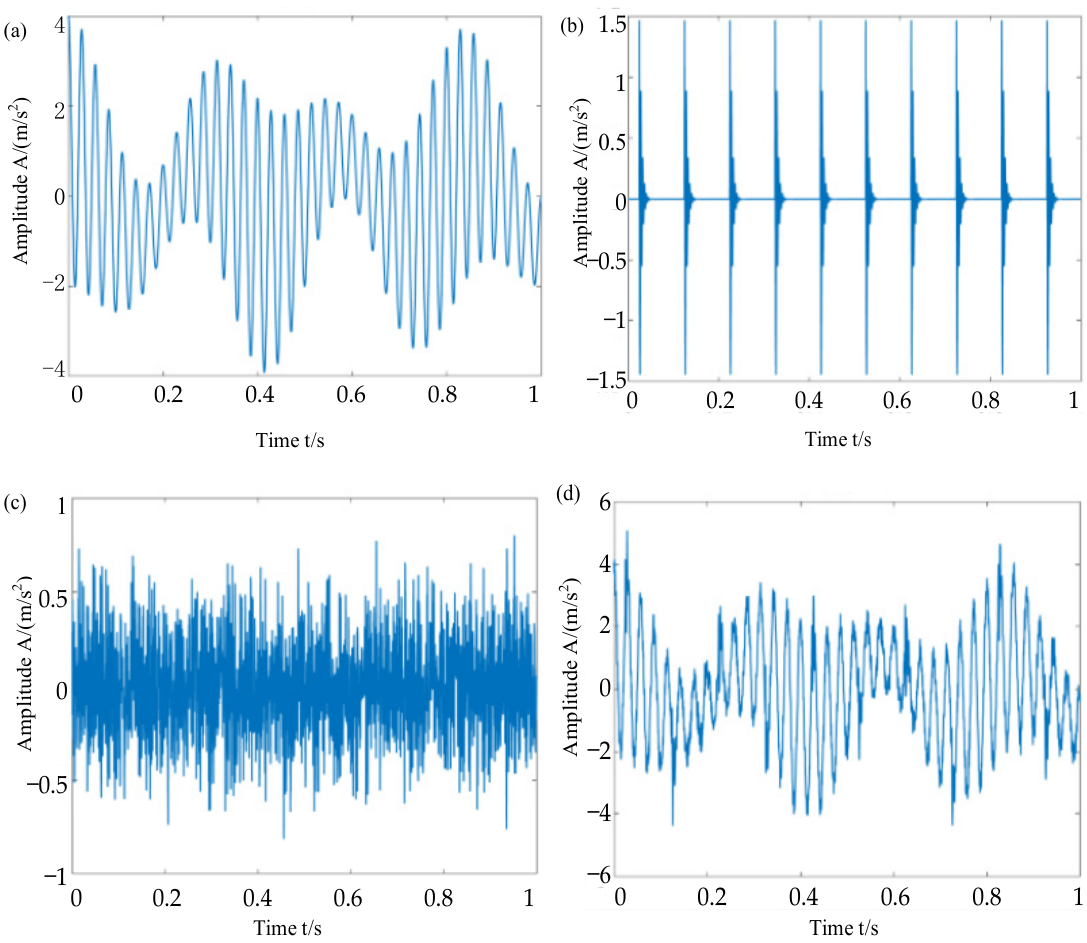
Figure 3. Synthetic signal time-domain waveform. ( a ) Harmonic components; ( b ) Impact component; ( c ) Noise; and ( d ) Synthetic signal.